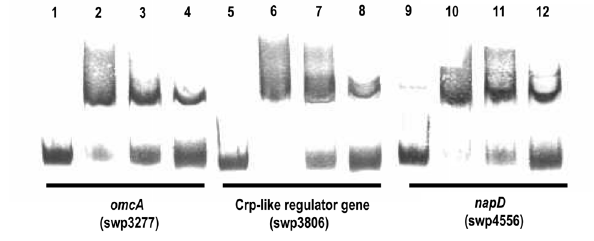
Figure 4. Fur binding to selected promoters ( omcA , Crp-like regulator gene and napD ) by EMSA. The binding assays were performed in the presence of 200 pmol Fur (lanes 2–4, lanes 6–8, lanes 10–12) and 0.2 pmol DIG-labeled (lanes 1–12) promoter DNA. Non- specific competitor DNA (50 m g/ml Salmon Sperm DNA) was used in all these binding reactions to control for the presence of unspecific binding. Specific competitors (2 pmol and 20 pmol unlabeled probes) were added respectively in lane 3, 4; lane 7, 8; lane 11, 12 to verify the specificity of a band resulting from protein-binding to the labeled